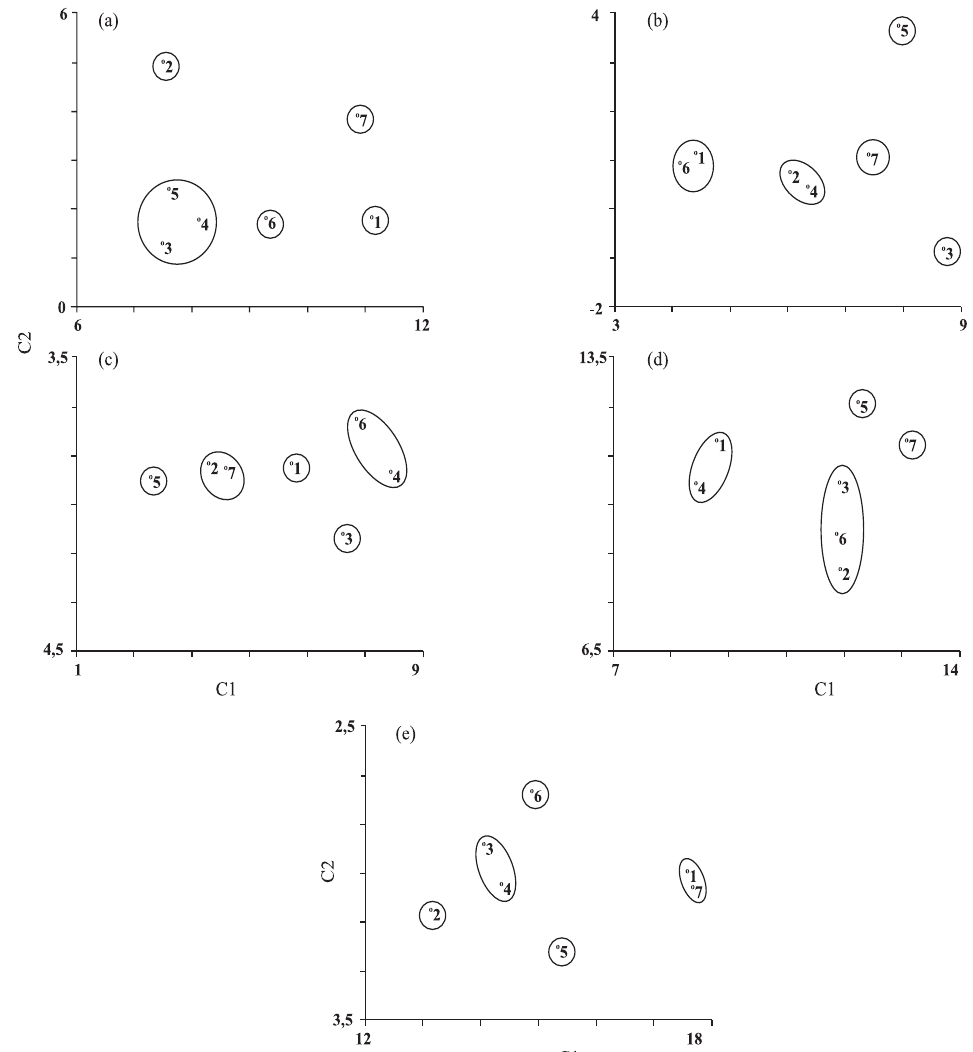
Figura 1. Dispersão gráfica em relação aos dois primeiros componentes principais, com base nas variáveis de conteúdo de C, N, P, K, Ca e Mg na parte áerea (a), folhedo (b), serapilheira (c), solo (d) e solo + planta (E) de diferentes plantios florestais no sudeste da